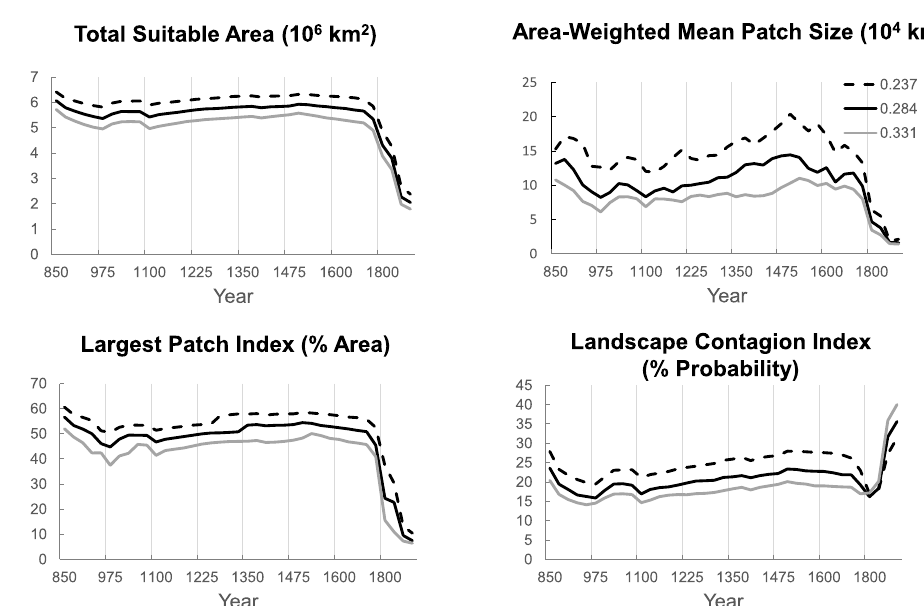
Figure 2. Loss of suitable habitat from 850 to 2015. Masked areas (Hainan Island and part of Pakistan) have been excluded from analyses, and for visual clarity all of China is not shown. Shaded area (Borneo) is outside the currently known historic range. ( a ) Habitat suitability predicted on the basis of elevation and the Land-use Harmonization (LUH) variables from the year 2000. ( b ) Binarized map where 1 (yellow) indicates “suitable” areas with values above 0.284 (threshold of ‘maximum training sensitivity plus specificity’) and 0 (blue) indicates “unsuitable” areas. ( c ) Changes in the extent and spatial configuration of suitable habitat, where each curve corresponds to the given threshold value. Total Suitable Area is the sum of all suitable habitat across the range. Area-Weighted Mean Patch Size is the weighted average of patch sizes. The Largest Patch Index is the percentage of total area occupied by the largest patch. The Landscape Contagion Index can be thought of as a measure of homogeneity, with higher probabilities representing fewer, more clumped patches. See Table S4 for complete list of fragmentation